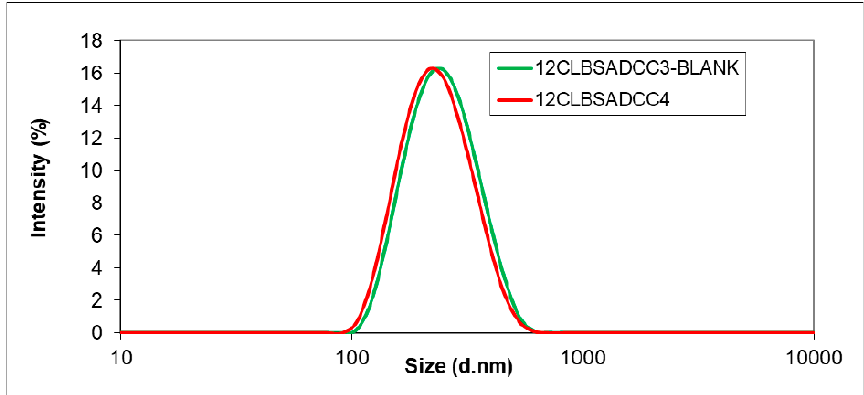
Figure 2. Particle size distribution of BSA encapsulated nanoparticles using DCC as cross-linker (red line) and the blank sample (green line).